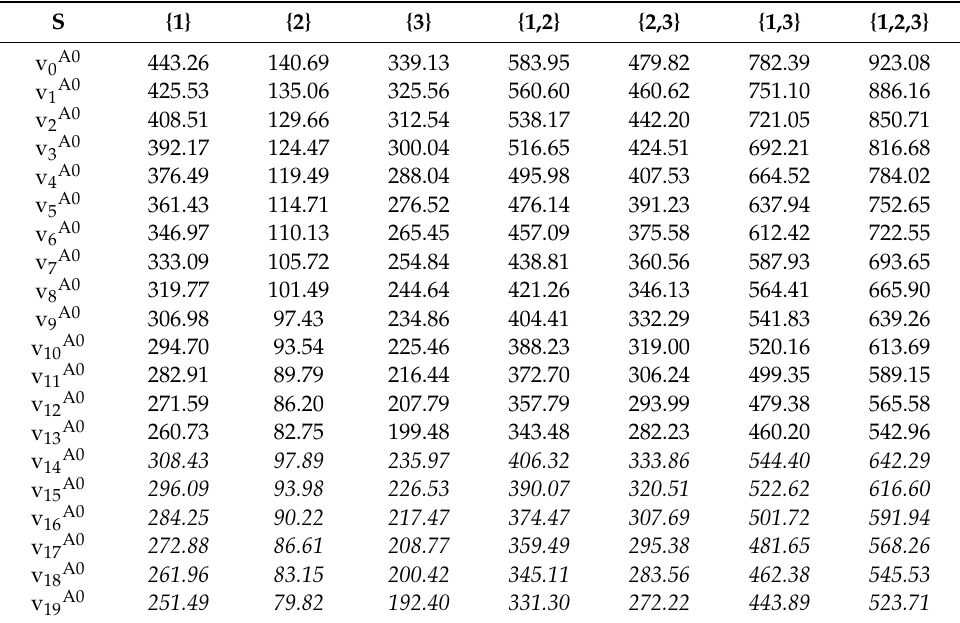
Table A5. Annual revenues for coalitions in games v tA0 for t = 0, . . . , 19 under Alternative